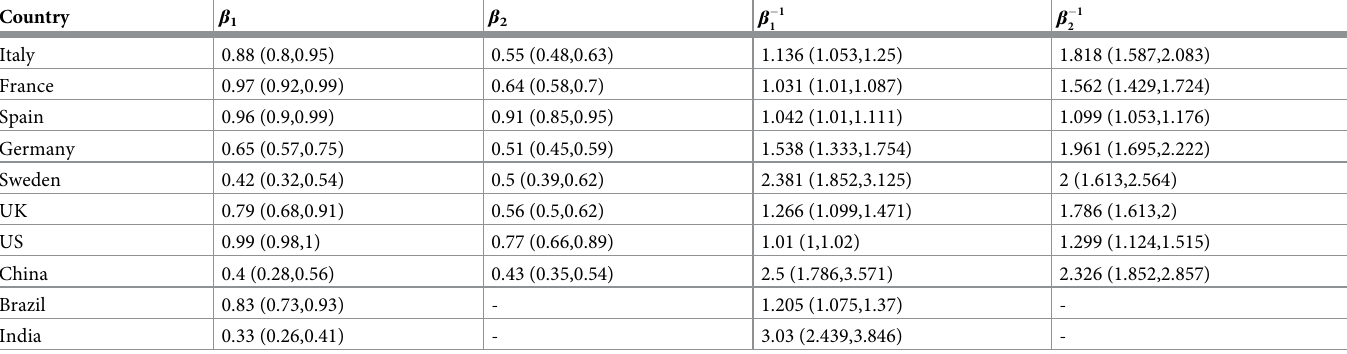
Tables 1–3 present the posterior median and corresponding 80% posterior intervals for the model parameters. Further details for the other baseline parameter priors considered can be found in S4 Appendix. In most countries, the posterior interval for μ than μ , indicating a reduction in the baseline rate of events from the beginning to later stages 1 of the epidemic. The exception to this is the U.S. The results for the U.S. are highly sensitive to the prior choice; thus, wider priors return higher posterior estimates than expected when Table 3. Phase 1 versus Phase 2 median and 80% intervals for triggering kernel parameters, β 1 and β 2 and the means of their respective geometric distributions, β (cid:0) 1 and β (cid:0) 1 2